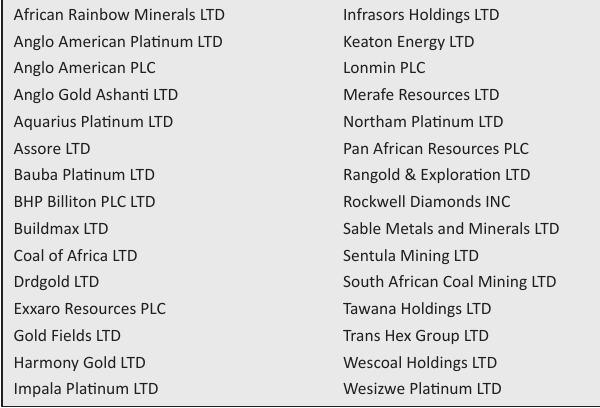
BOX 1: Sample of Johannesburg Stock Exchange listed mining companies used in the